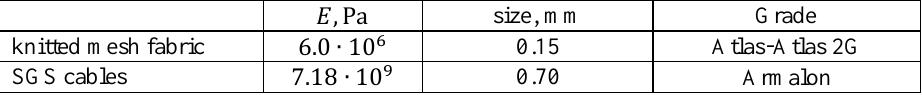
Table 1. Physical properties of the knitted mesh fabric and the SGS